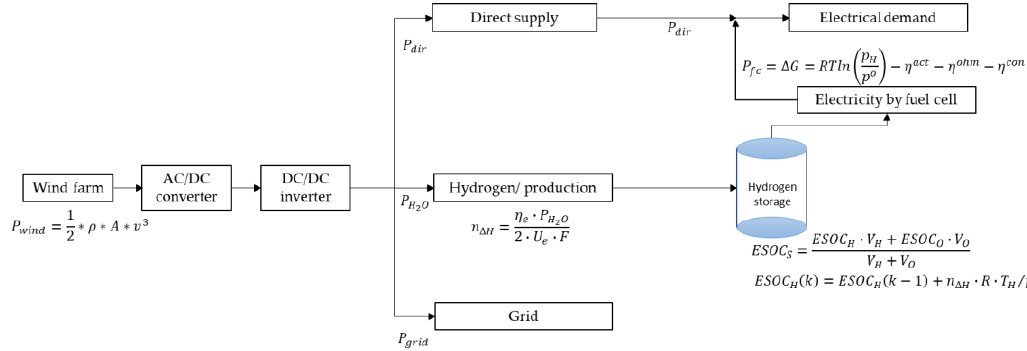
Figure 5. Energy flow in the proposed system.